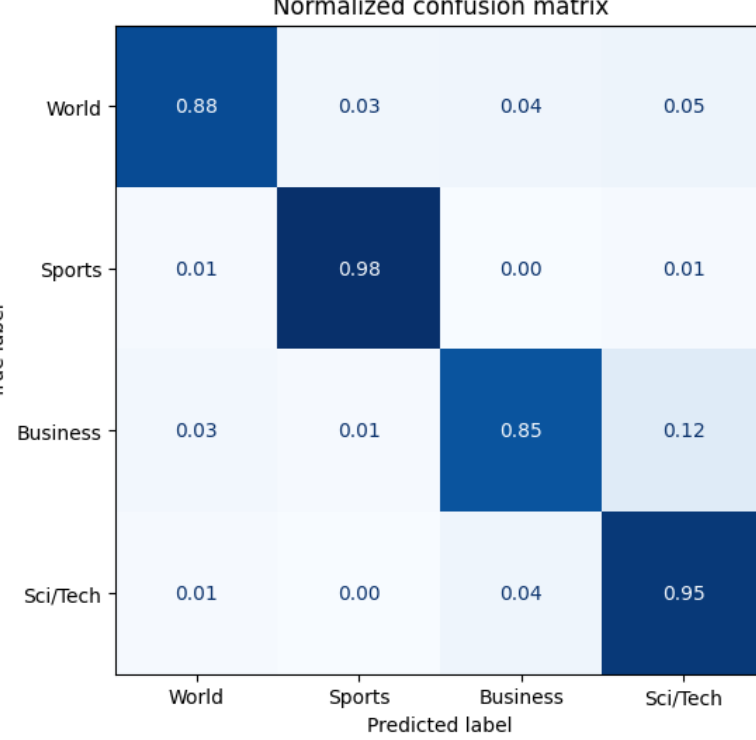
Figure A2. Antipode3 Run3 Confusion Matrix on AG-News.